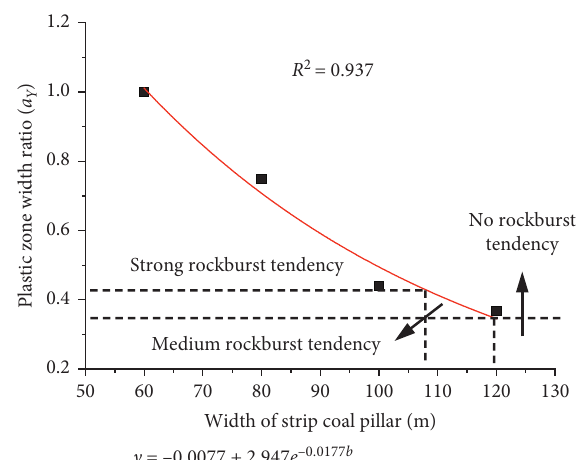
Figure 4: Fitting relationship of plastic zone width ratio and strip coal pillar.